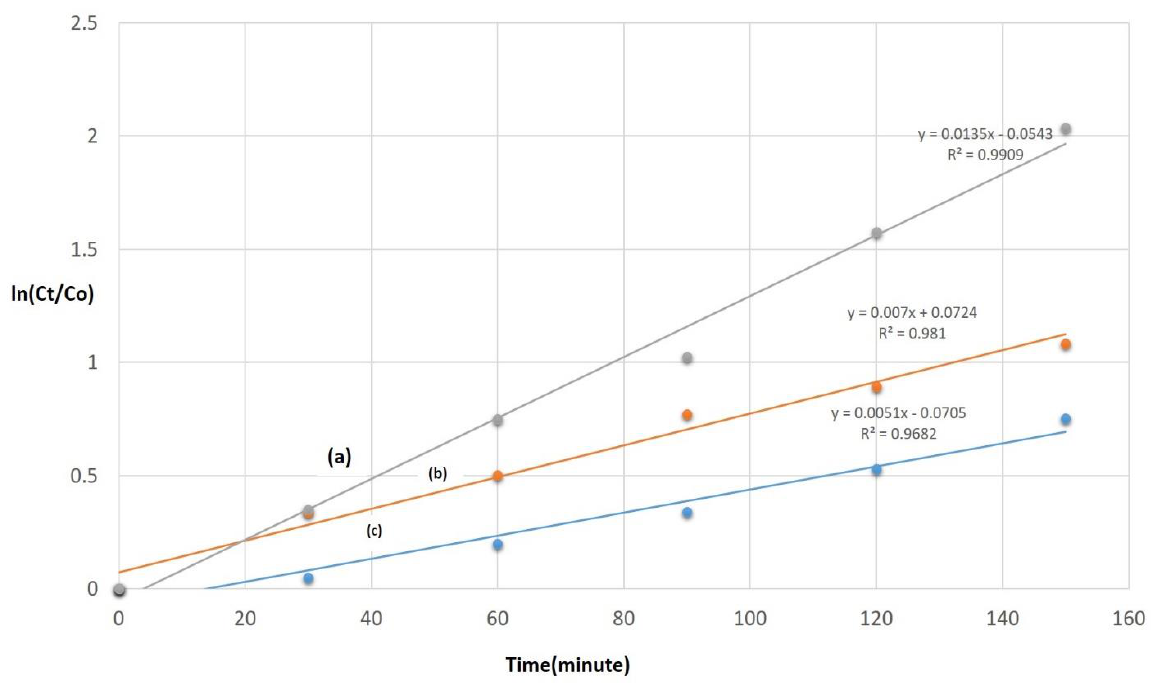
Figure 8. ( a ) The first-order kinetic of 0.01 Ag/TiO 2 composite. ( b ) The first-order kinetic of 0.1 Ag/TiO 2 composite. ( c ) The first-order kinetic of 0.5 Ag/TiO 2 composite. Table 2. kinetics study of photocatalytic degradation of methylene